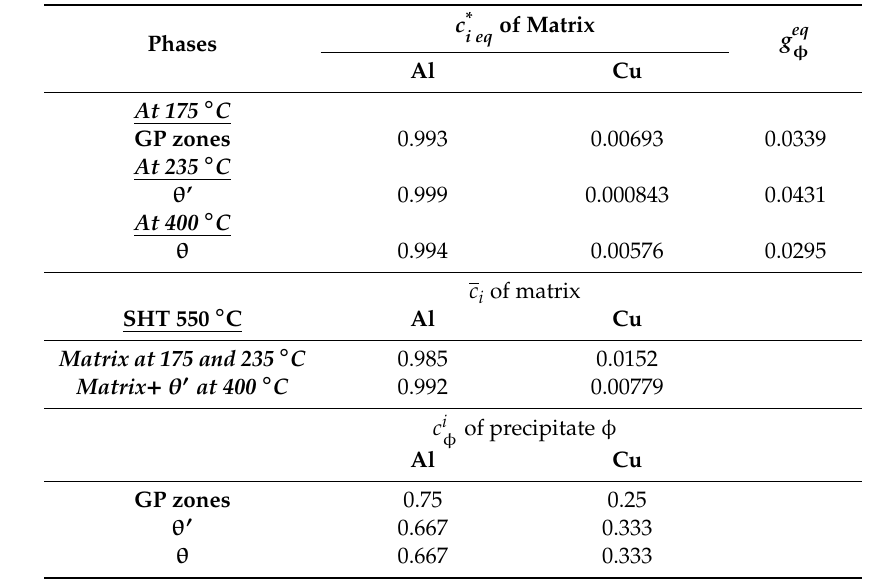
Table A2. Binary Al-3.5 wt%Cu alloy, data from